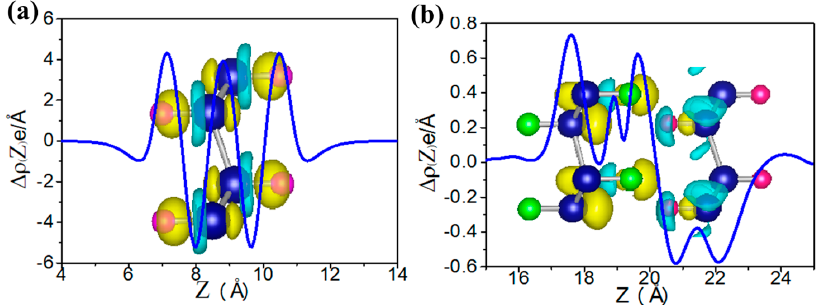
Figure 3. The plane-integrated electron density difference, Δ (Z), for the H–Ge–H ( a ) and the